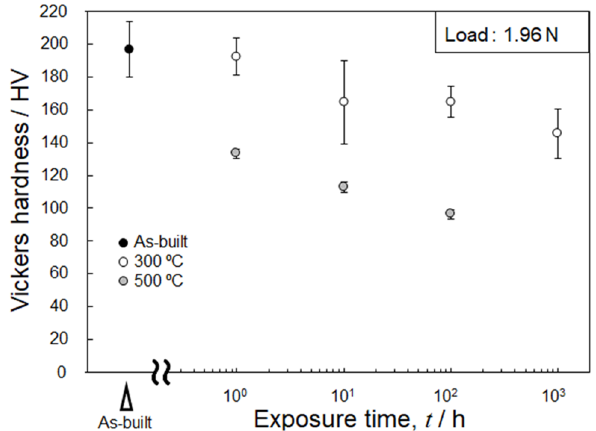
Figure 7. Changes in hardness of the L-PBF-built Al–15%Fe alloy samples as a function of exposure time at 300 and 500 °C.